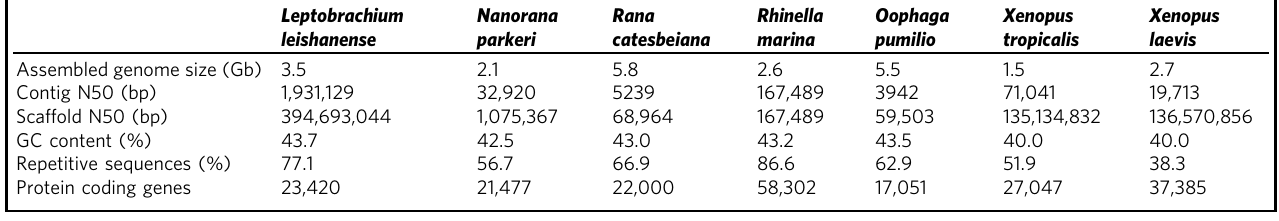
Nanorana parkeri